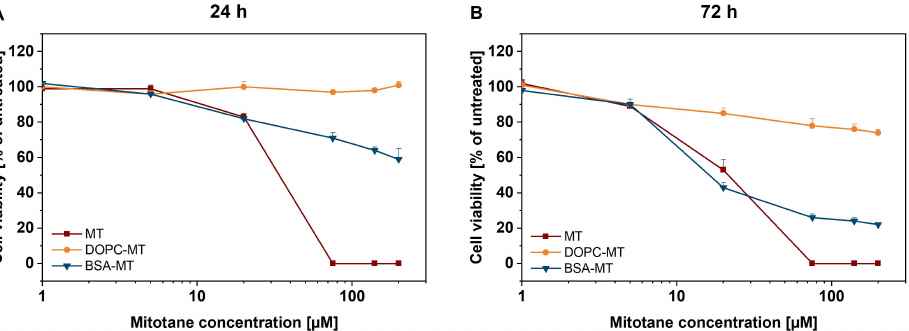
Figure 6. Representation of 3D tumor spheroids: in vitro cytotoxicity of albumin-stabilized mitotane (BSA-MT), liposomal mitotane (DOPC-MT), and free mitotane (MT). Cell viability of NCI-H295R 3D multicellular tumor spheroids was analyzed using the CellTiter-Glo ® 3D cell viability assay ( A ) 24 h and ( B ) 72 h after sample treatment. Data are expressed as mean ± SD, n =